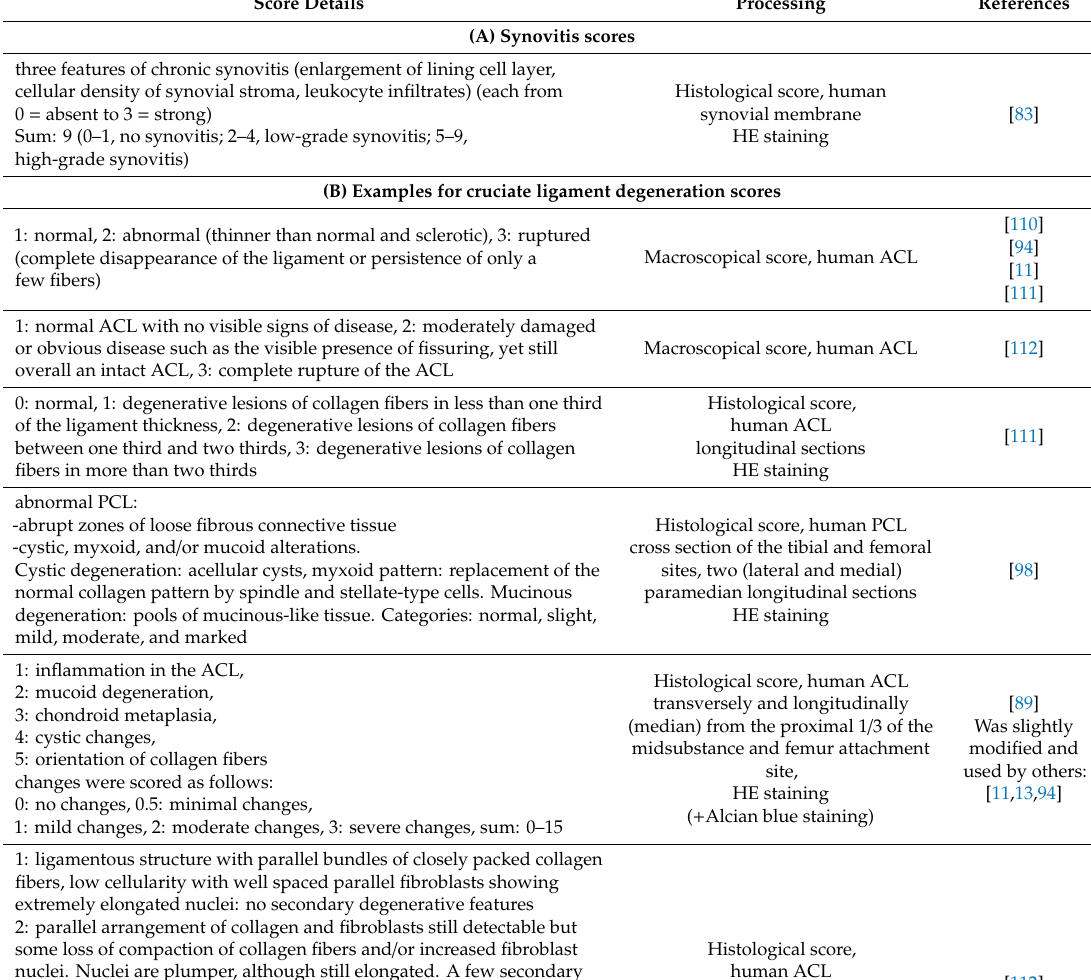
(A) Synovitis scores